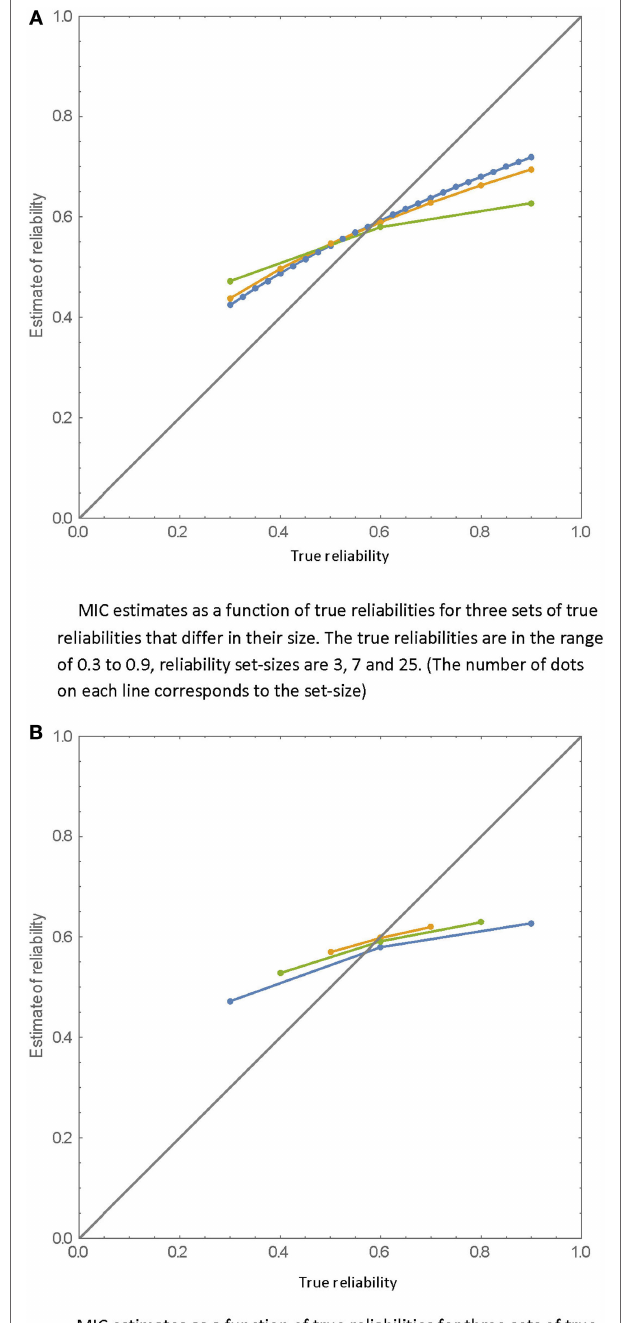
FigUre 1 | MIC estimates as a function of true reliabilities. (a) MIC estimates as a function of true reliabilities for three sets of true reliabilities that differ in their size. The true reliabilities are in the range of 0.3–0.9, reliability set-sizes are 3, 7, and 25. (The number of dots on each line corresponds to the set-size.) (B) MIC estimates as a function of true reliabilities for three sets of true reliabilities that differ in their spread. There are three reliability values per set, with true reliabilities that are in the range of 0.3–0.9, 0.4–0.8, and 0.5–0.7.